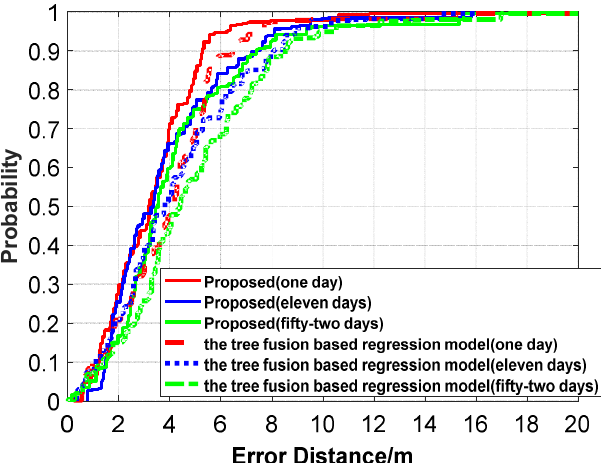
Figure 23. Comparison of CDF positioning errors between the proposed algorithm and the tree-